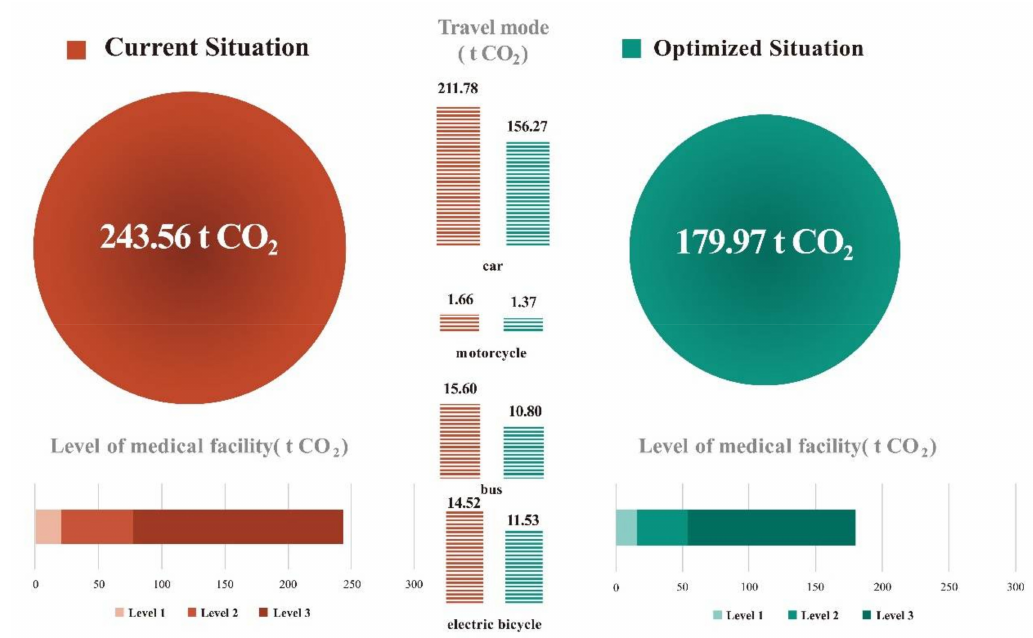
Figure 6. Changes in the quantitative structure of travel-related carbon emissions.